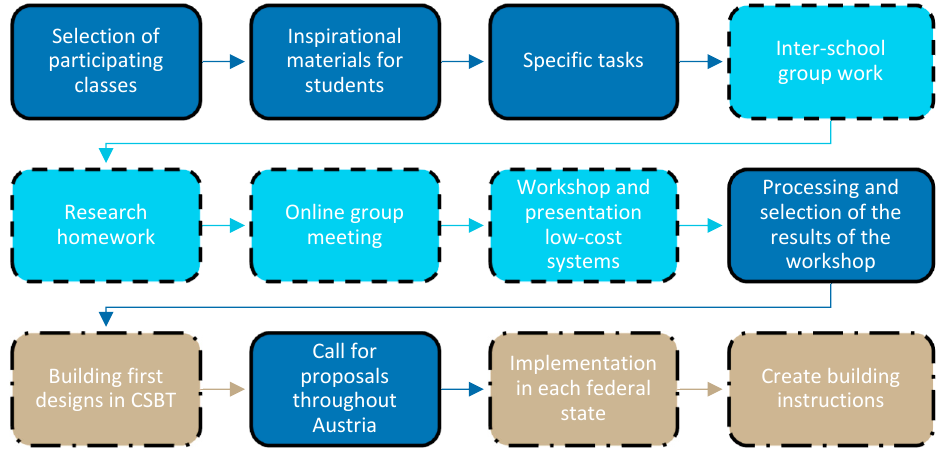
Figure 7. Development process of low-cost greening systems; dark blue, framed throughout: work in the project team; light blue, dashed framed: integration of the school classes of the CSBT and the HBLFA; beige, dash dot framed: joint work of the project team with students of the CSBT and other selected school classes throughout Austria.